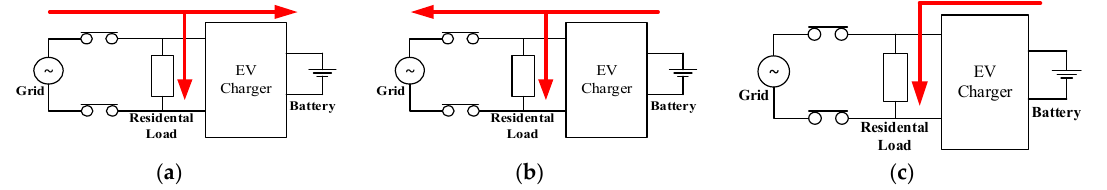
Figure 1. Operating modes of the bi-directional electric vehicle (EV) charger. ( a ) grid-to-vehicle (G2V) mode; ( b ) vehicle-to-grid (V2G) mode; (c) vehicle-to-home (V2H) mode [12] .